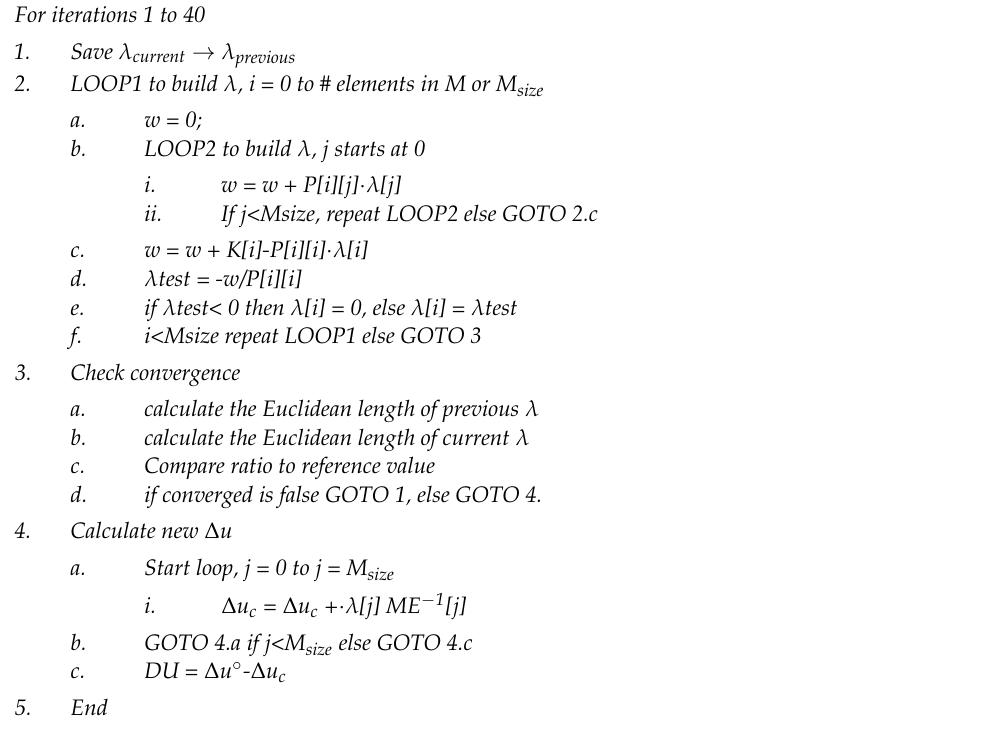
Algorithm 12: Functional Flow of Hildreth’s Quadratic Programming solution for